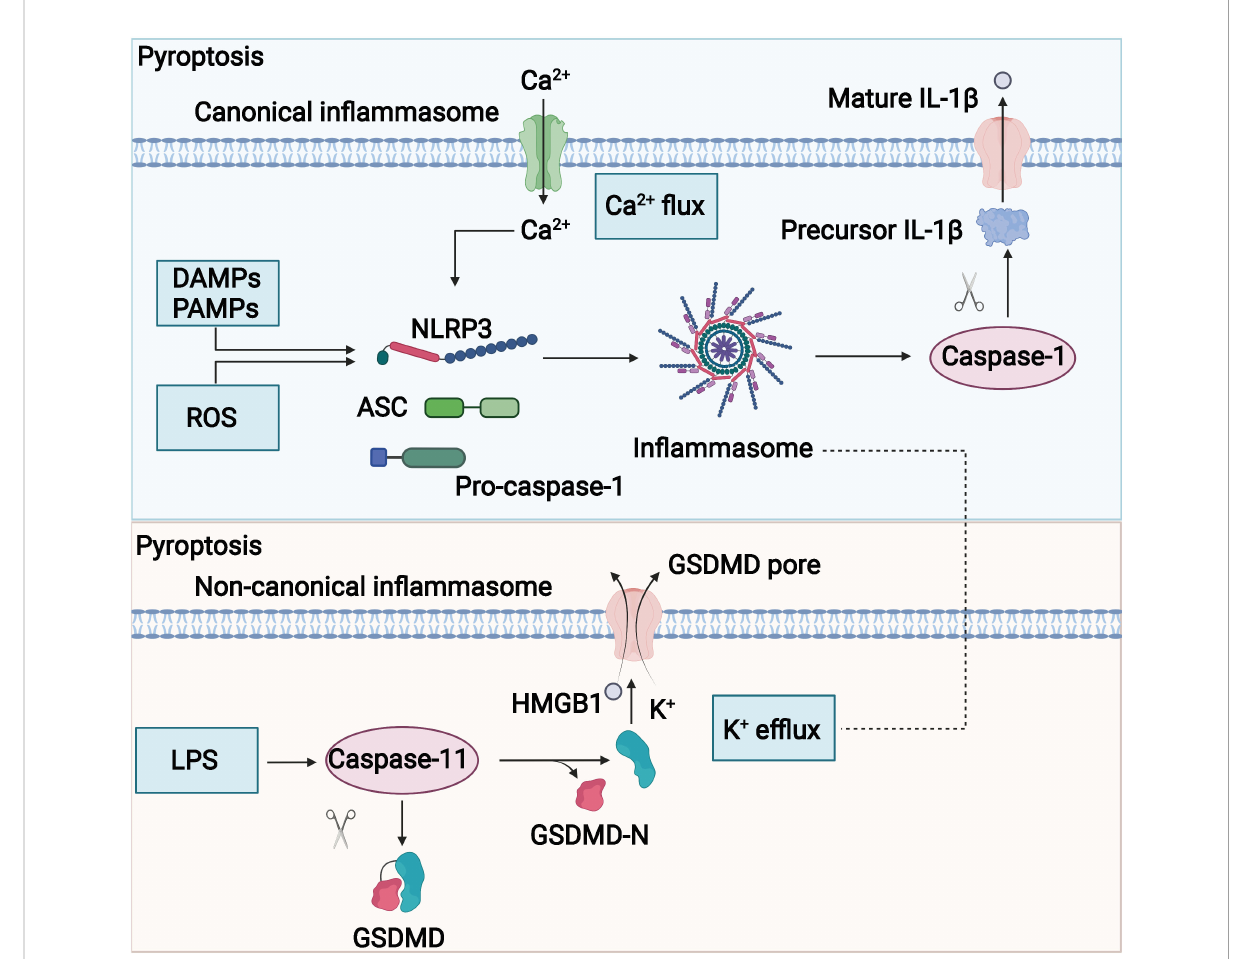
FIGURE 4 Potential mechanism of pyroptosis. The molecular mechanisms of pyrolysis mainly include canonical and noncanonical